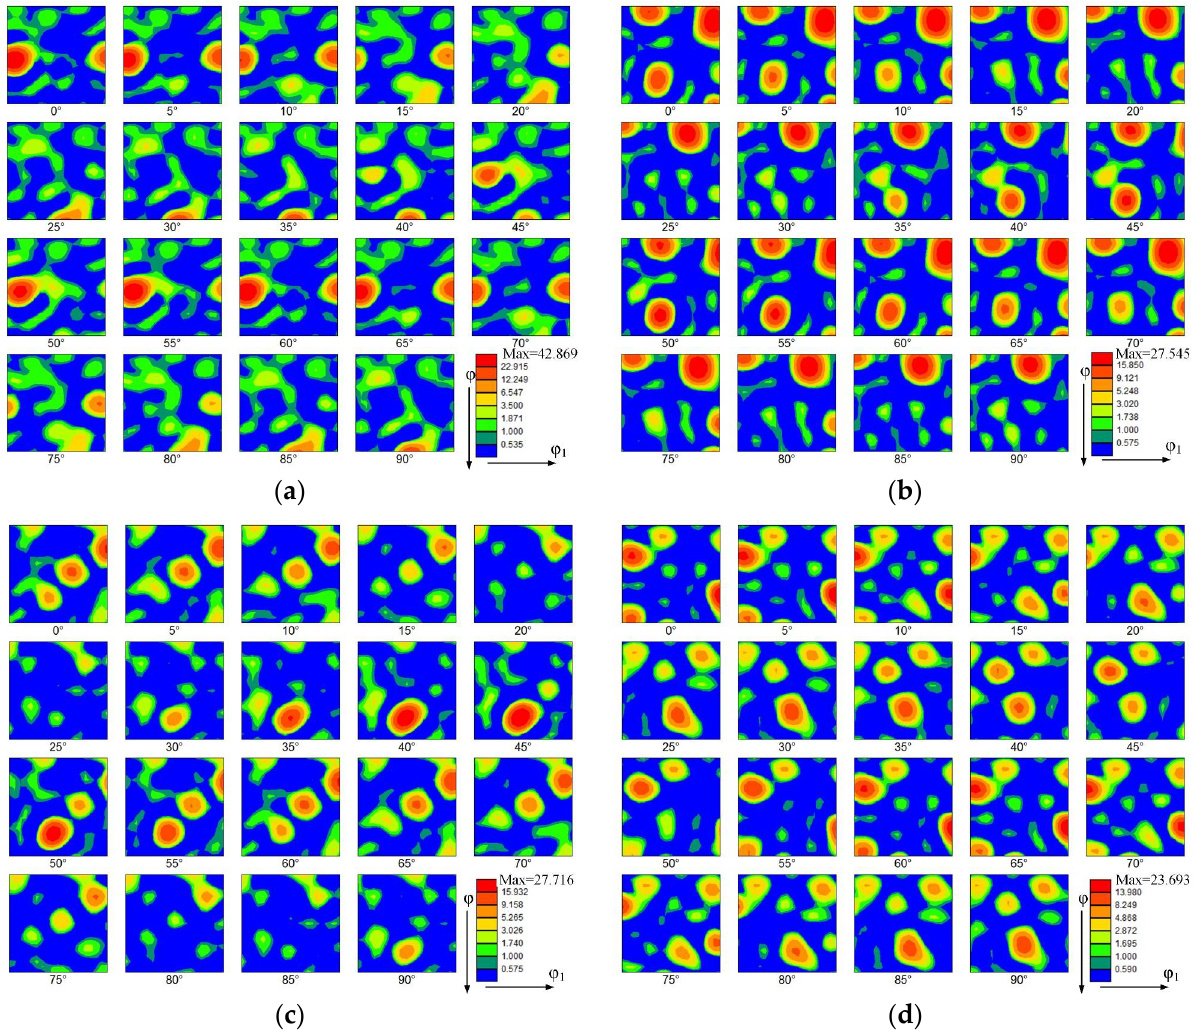
Figure 7. Orientation distribution function (ODF). ( a ) The top zone without La 2 O 3 , ( b ) The top zone with La 2 O 3 , ( c ) The bottom zone without La 2 O 3 and ( d ) The bottom zone with La 2 O 3 . The ODFs of the bottom zone without La 2 O 3 and with La 2 O 3 are shown, respectively,